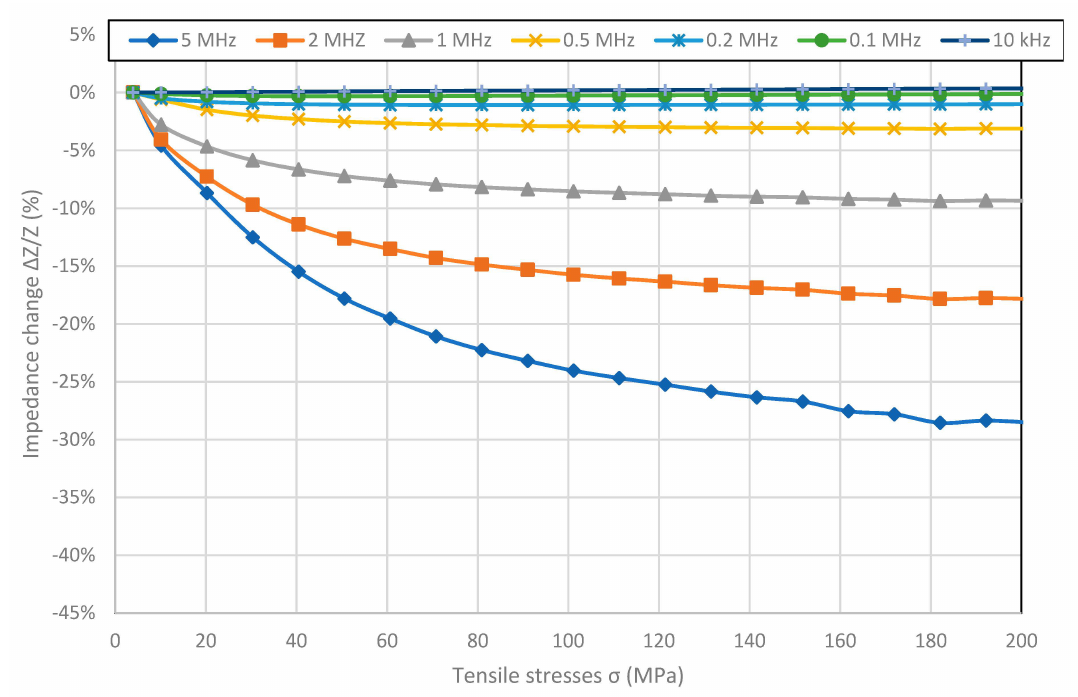
Figure 2. The tensile stress σ dependence of impedance Z in Fe 80 B 11 Si 9 sample.